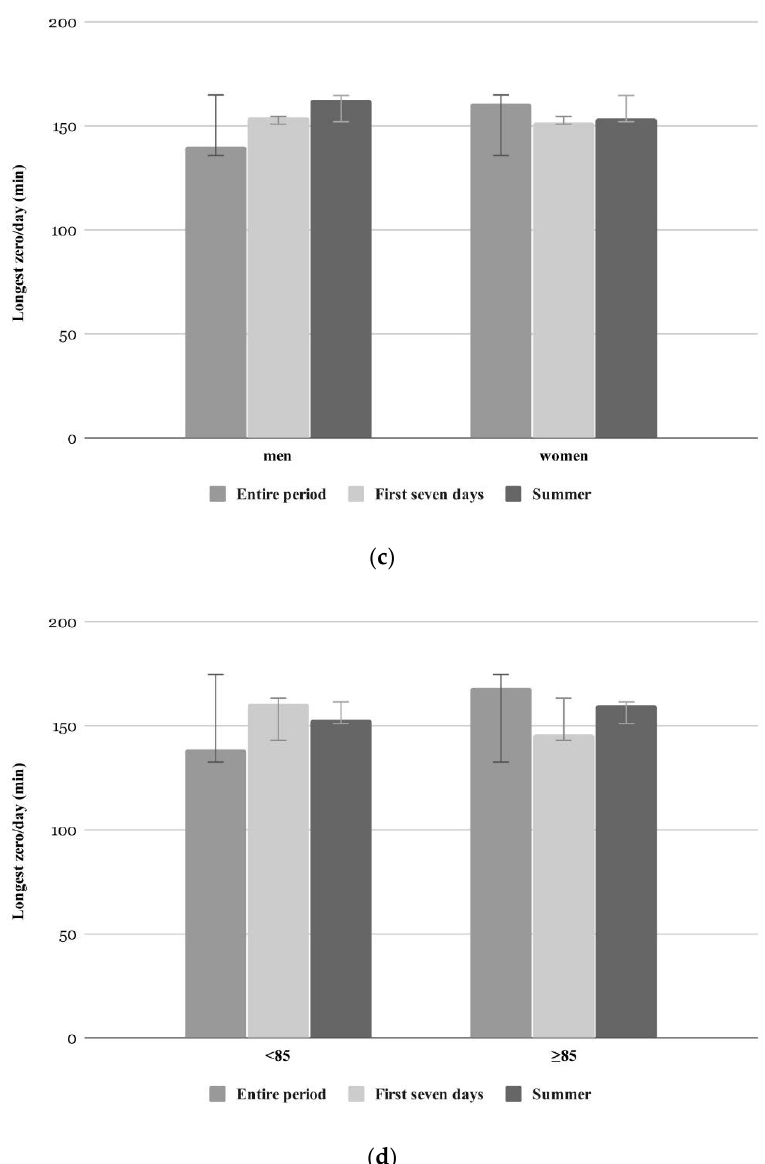
Figure 4. Daily sedentary behavior shown as sedentary minutes ( a , b ) and longest period of minutes with zero steps (longest zero, ( c , d )) of different time periods (entire period ( n = 17), summer ( n =